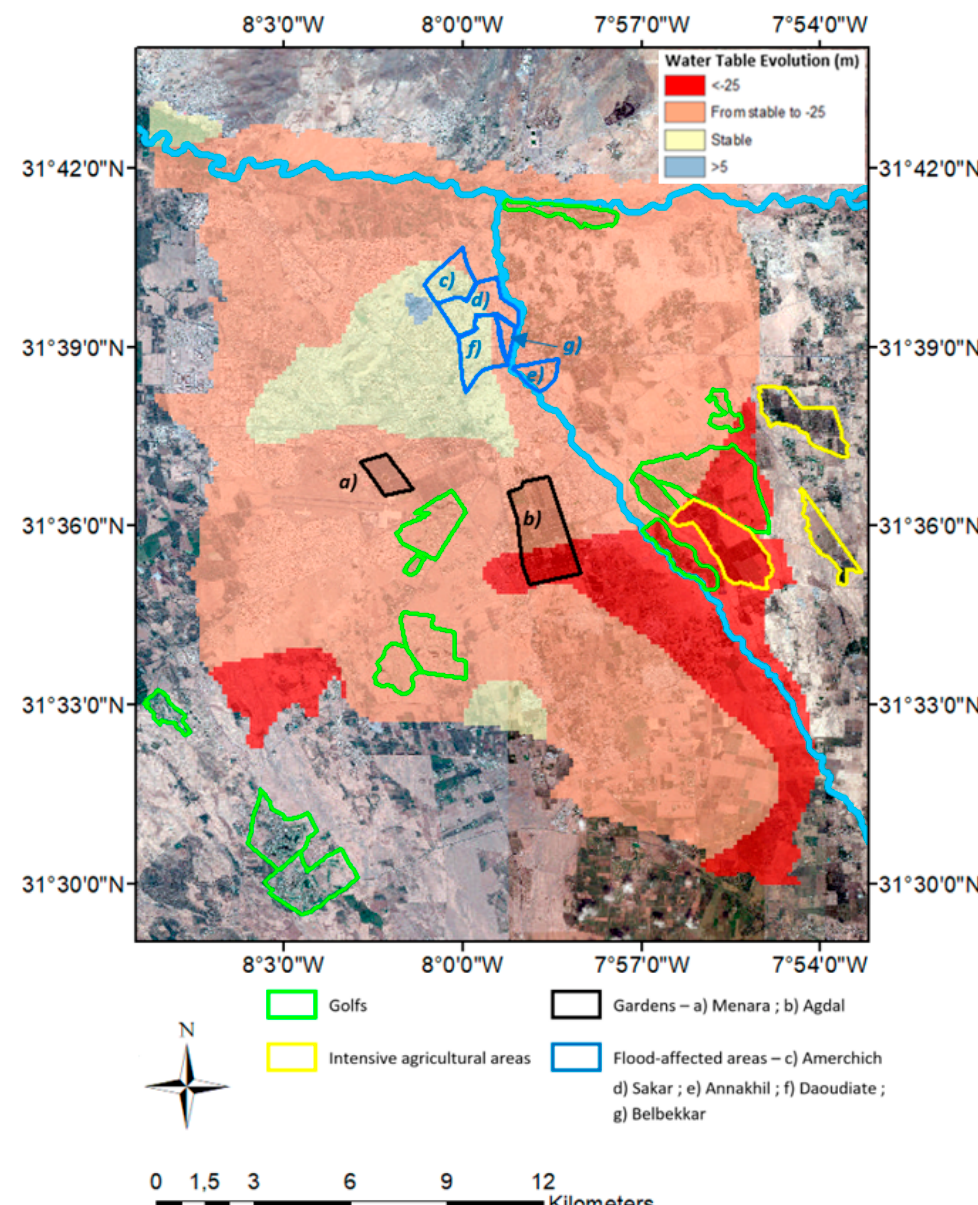
Figure 9. Synthetic map of the fluctuation of groundwater between 1986 and 2019. Areas a and b represent gardens. Areas c, d, e, f and g are flood-affected zones.